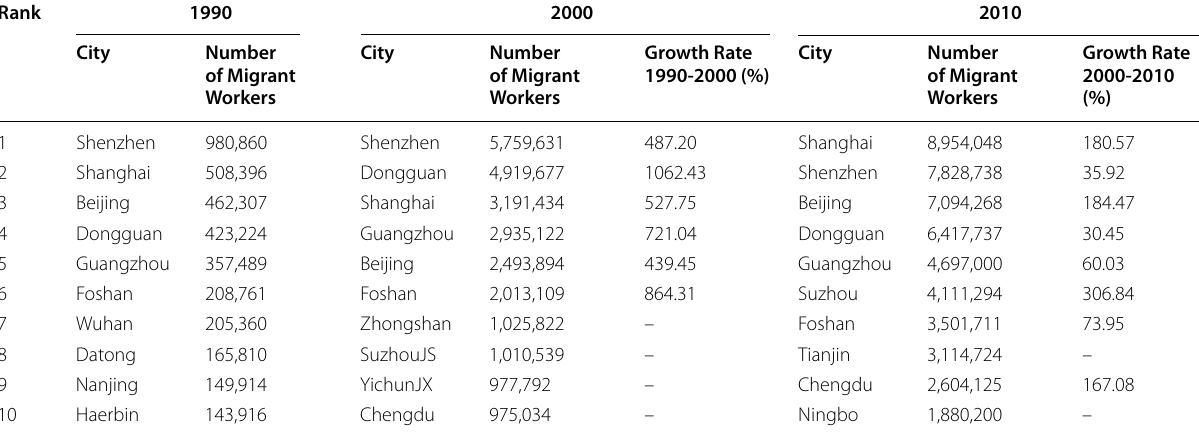
Table 4 Top 10 cities with the most immigrant population in 1990, 2000, and 2010